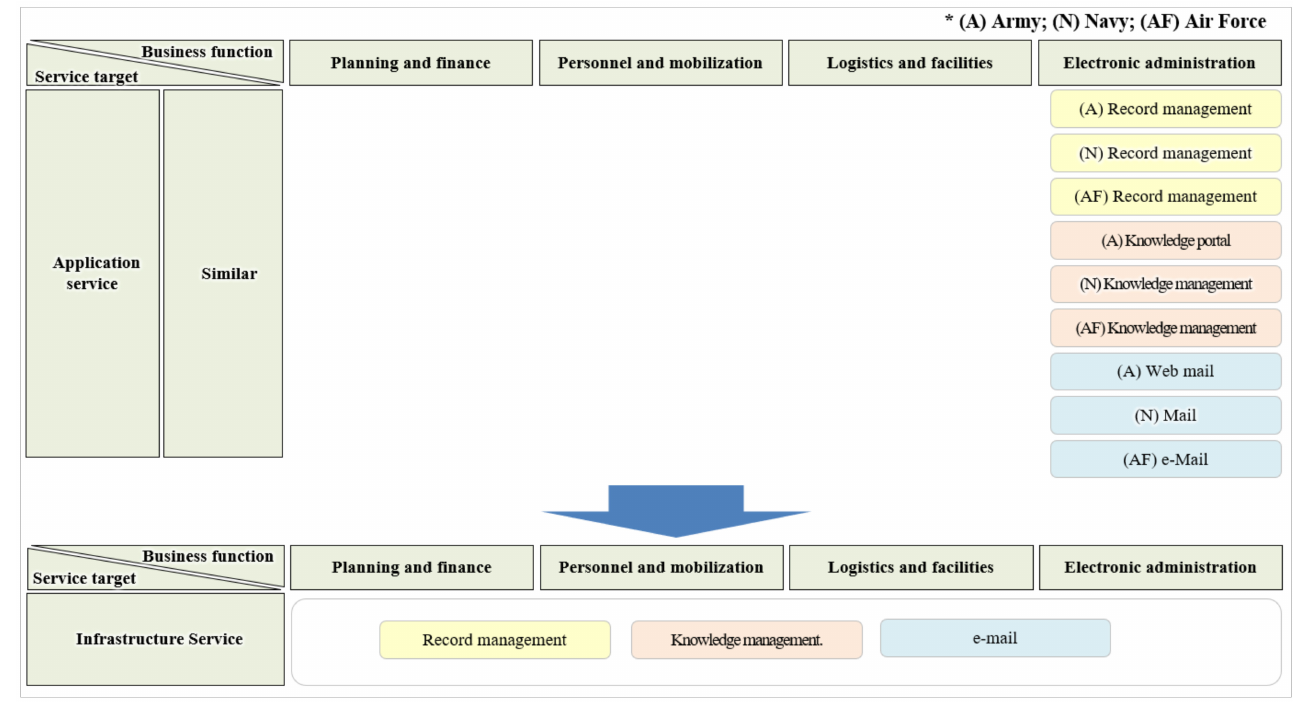
Figure 6. Example of basic service